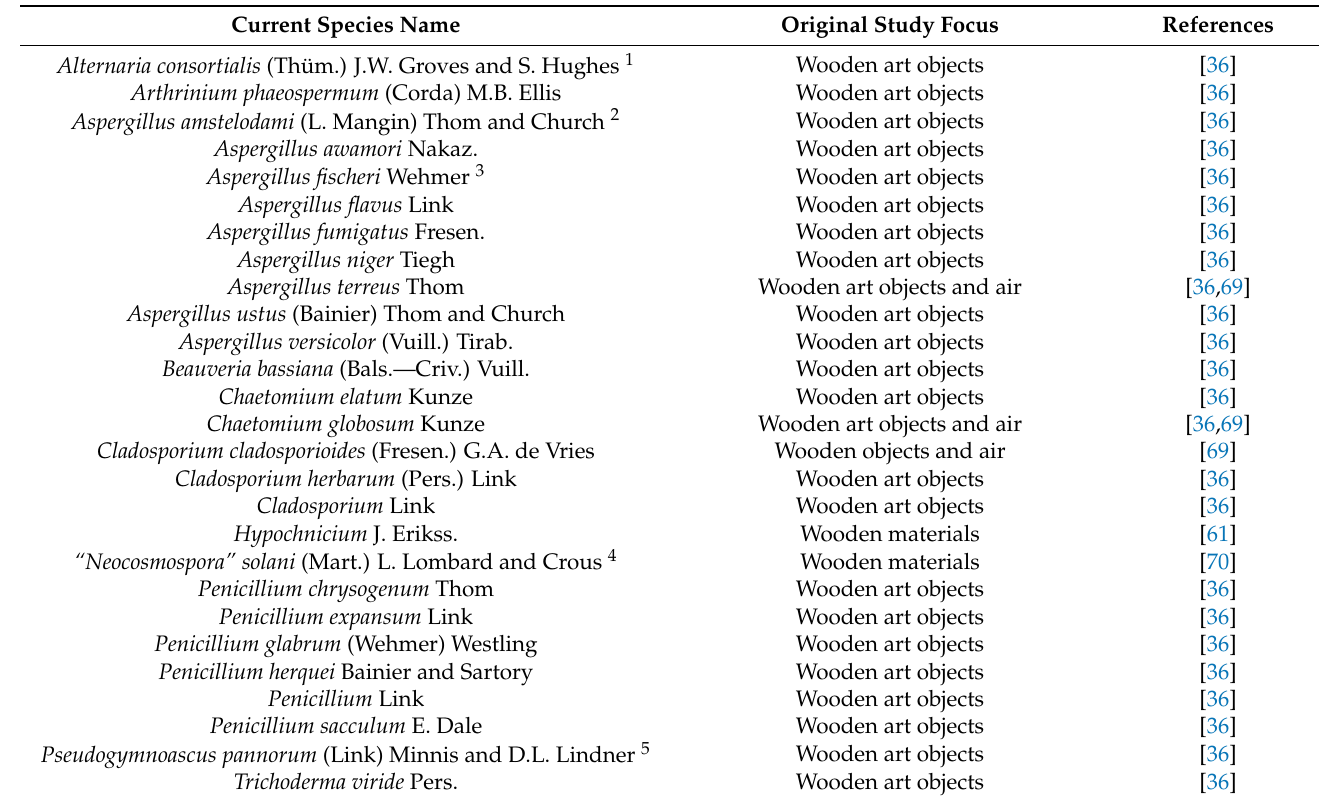
Table 3. Overview of fungal species for which isolates have been identified as displaying ligninolytic abilities in biodeterio- rative plate